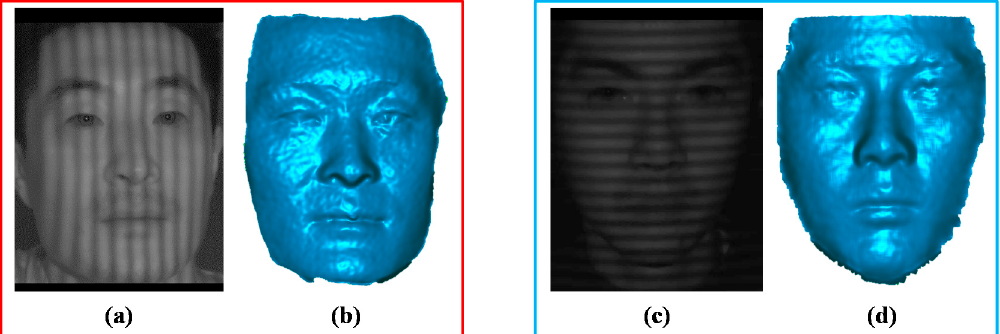
Figure 9. The measurement results of capturing the real faces. ( a ) One of the captured face images with infrared fringe from the first person; ( b ) 3D facial reconstruction result in front view of the first person; ( c ) One of the captured face images with infrared fringe from the second person; ( d ) 3D facial reconstruction result in the front view of the second